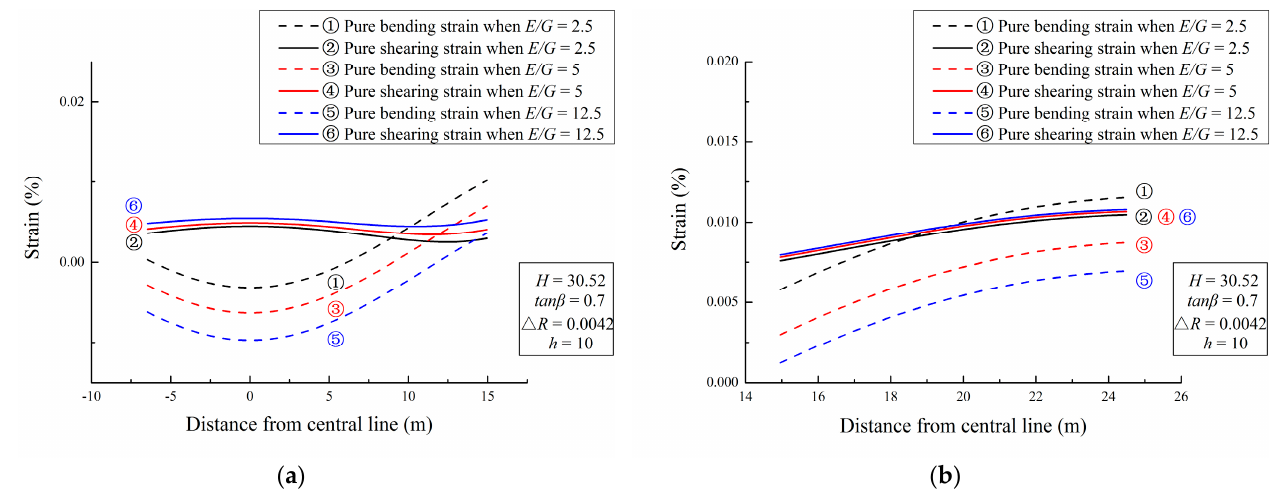
Figure 18. E ff ect of the ratio of Young’s modulus to the shear modulus on the tensile strain in ( a ) the sagging zones and ( b ) the hogging zones .